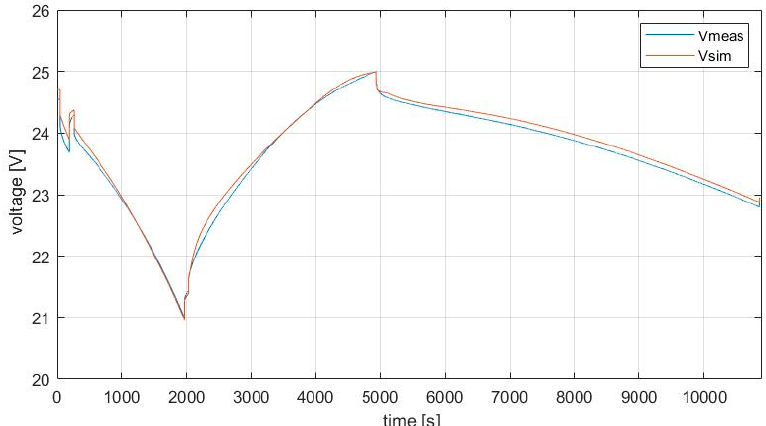
Figure 18. Measured voltage and simulated voltage.